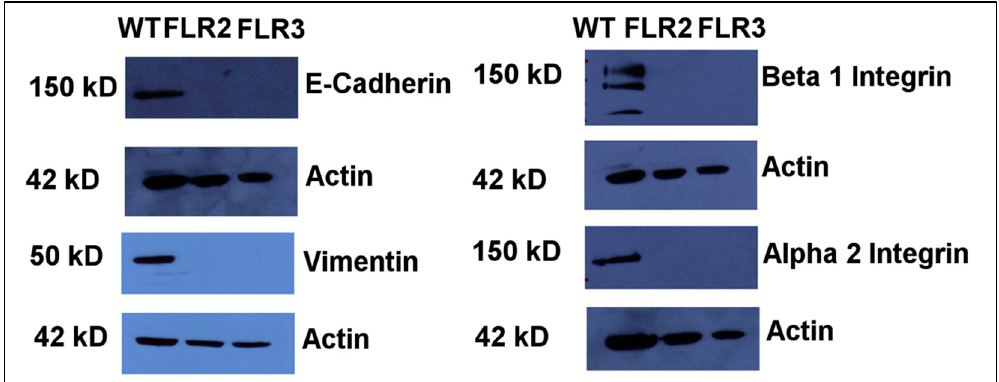
Figure 3. Expression levels of E ‐ cadherin, vimentin, and α 2 and β 1 integrins are reduced in FLR2 and FLR3 Panc ‐ 1 cells as compared to WT Panc ‐ 1 cells. Protein expression levels in WT, FLR2, and FLR3 Panc ‐ 1 cells were determined by Western blot. Actin was used as a loading control. Representative blots are shown.